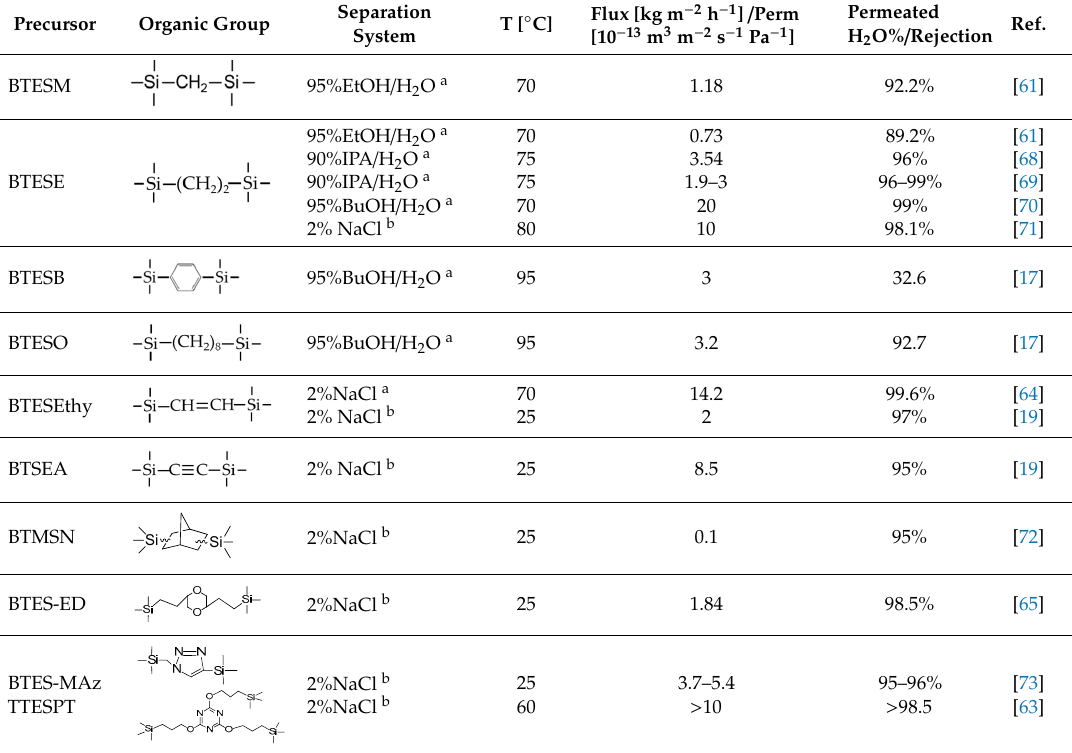
Table 4. Pendant-organosilica membranes and their performance in gas-phase separation.